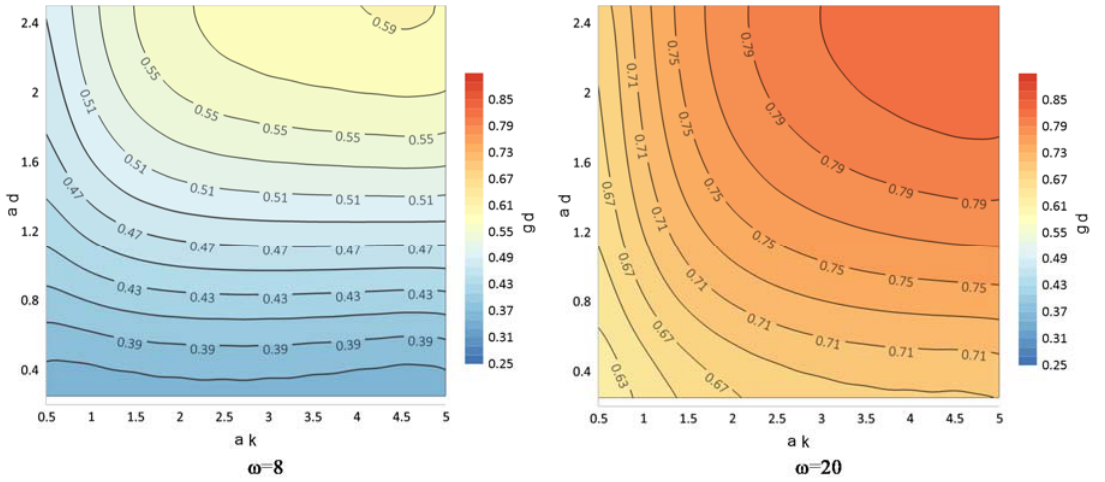
Figure 8. Gain maps in terms of γ d for various ω values.